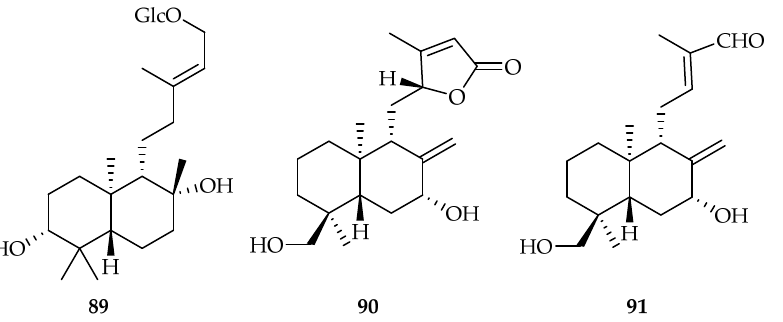
Figure 36. Structures of phocantoside A 89 [54], amentotaxin S 90 [55], and amentotaxin T 91 [55].